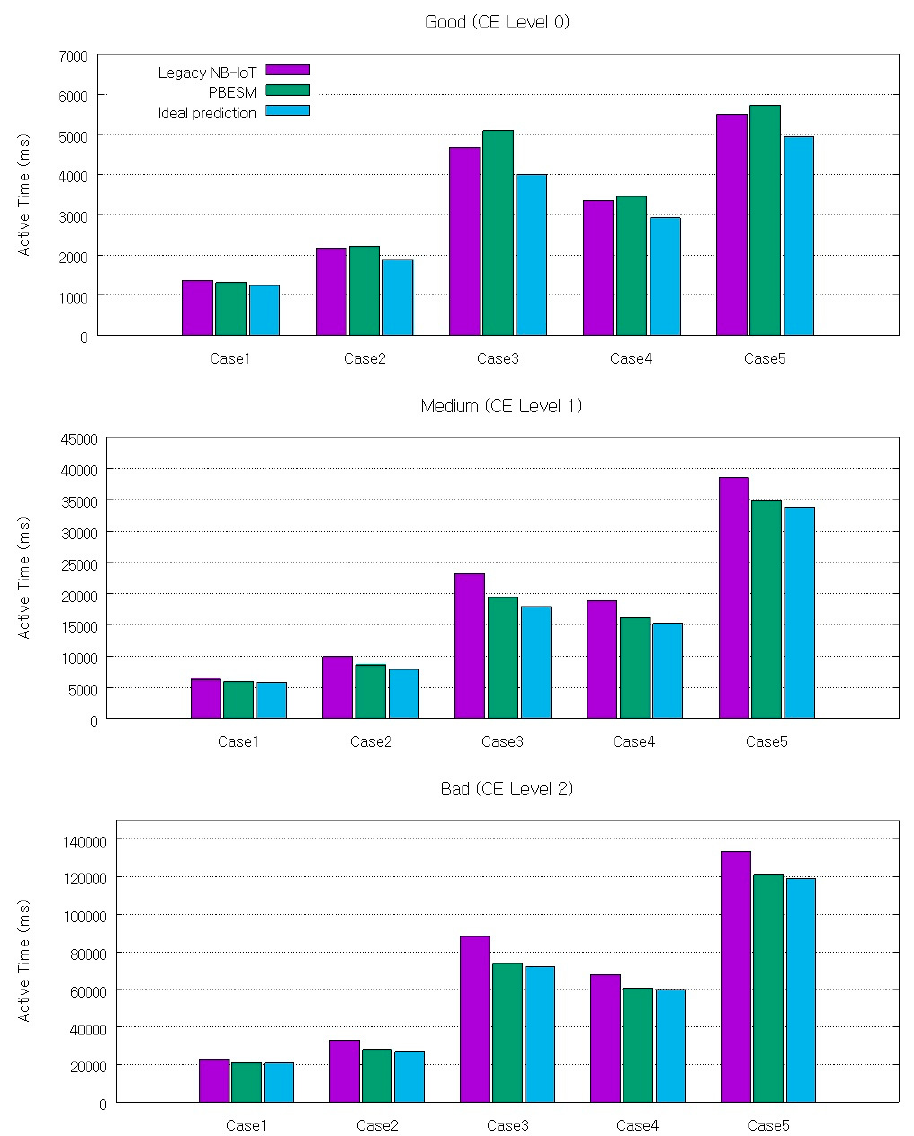
Figure 14. Active time according to channel condition for legacy NB-IoT, PBESM, and ideal prediction.